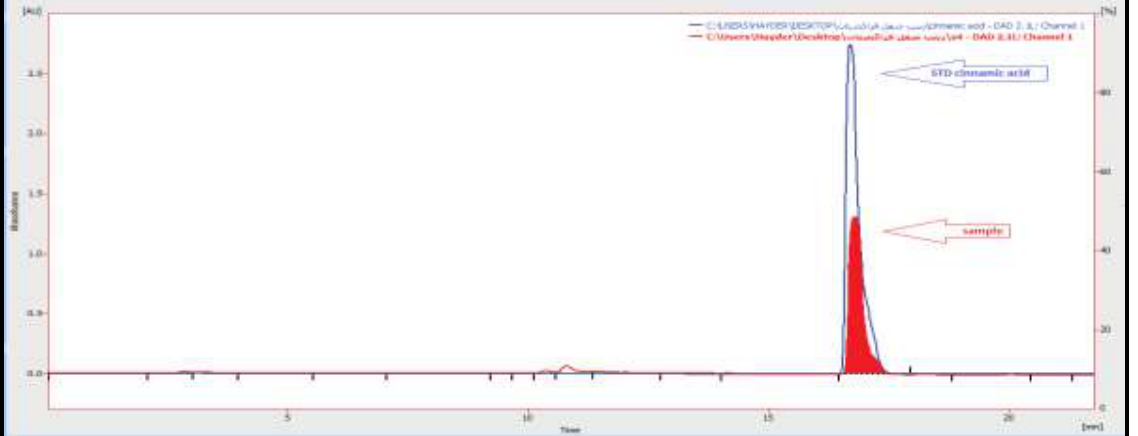
Figure 9.Analytic cinnamic acid standard and isolated compound(A1).